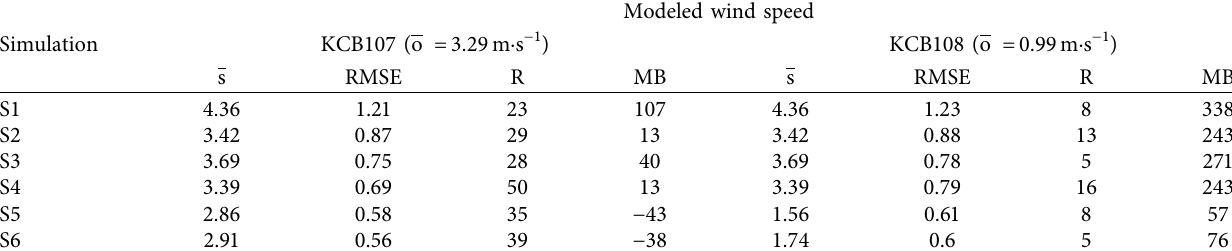
Table 10: Wind speed statistics over KCB107 and